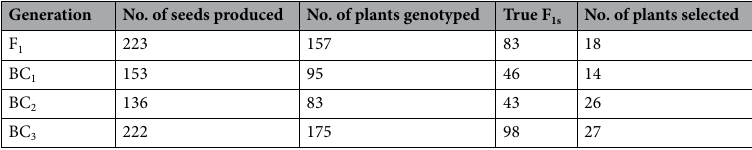
Table 1. Number of seeds produced, plants genotyped and selected in back cross generations.